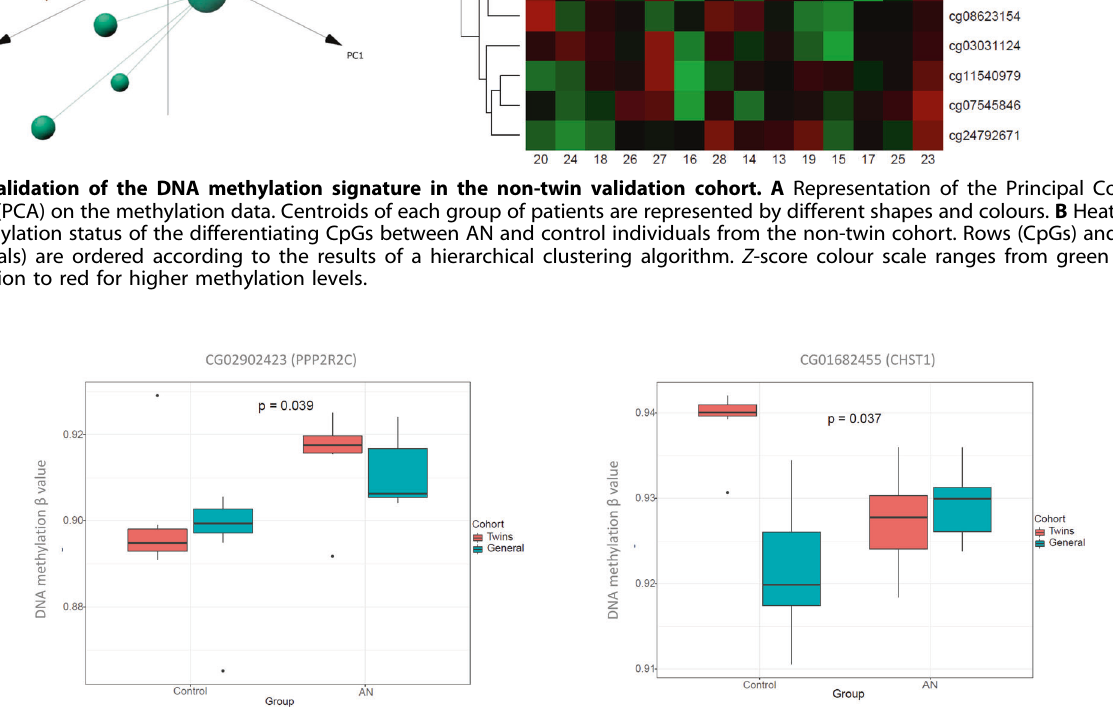
Fig. 5 DNA methylation levels for the validated CpGs between AN and controls in both cohorts. Box plots of the validated CpGs associated with the PPP2R2C and CHST1 depicting differences in methylation levels between AN and controls in the twin cohort (red) and in the non- twin cohort